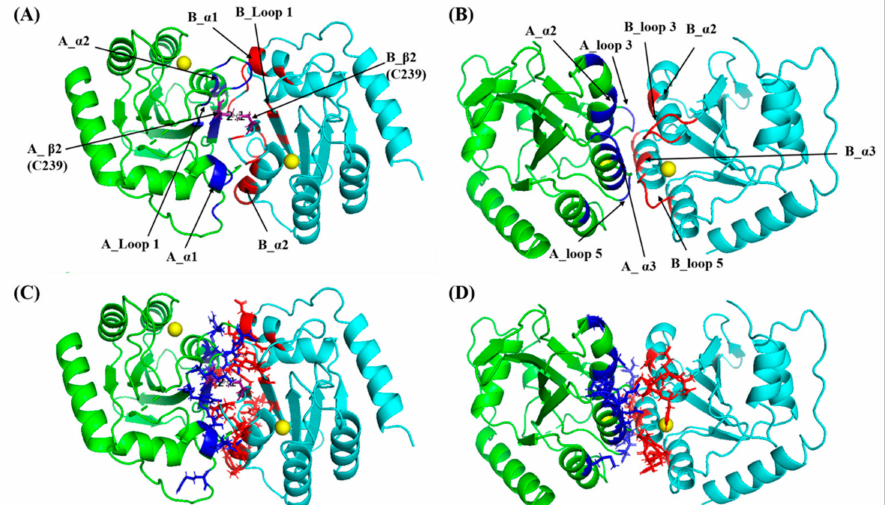
Figure 7. Models of the dimerization interface of A3B CTD *. Predicted interface models between two A3B CTD * molecules using the PRISM 2.0 webserver. A3B CTD * molecule A (green, dimerization interface in blue) and A3B CTD * molecule B (cyan, dimerization interface in red) with Zn 2+ (yellow sphere) in active site. ( A , C ) Model 1 interface with a calculated ∆ G ~ − 38.12 kcal/mol. ( B , D ) Model 2 interface with a calculated ∆ G ~ − 18.6 kcal/mol. Models represented as cartoons in ( A , B ) have the chains and loops involved in the dimerization interface labelled, whereas in ( C , D ) residues involved in the dimerization interface are shown in stick